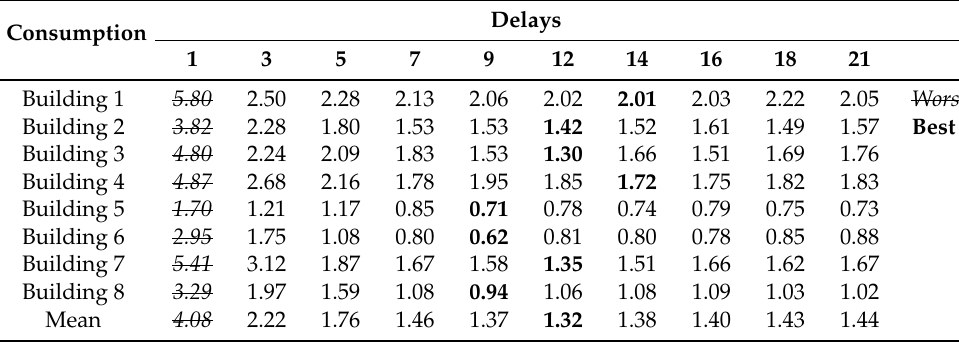
Table 1. MSE of the delay parameter obtained with the NAR model.